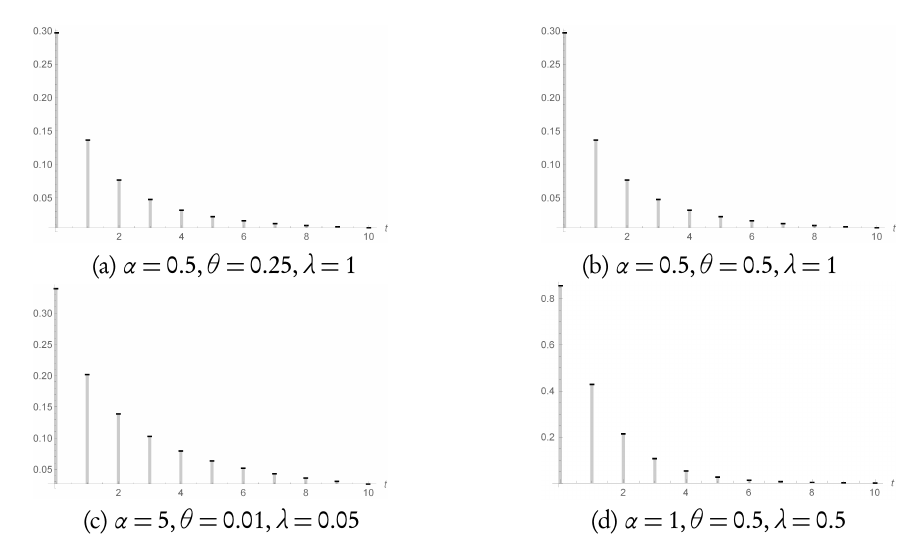
Figure 1 – Comparison of the shape of DNH distribution for different values of α , θ and λ